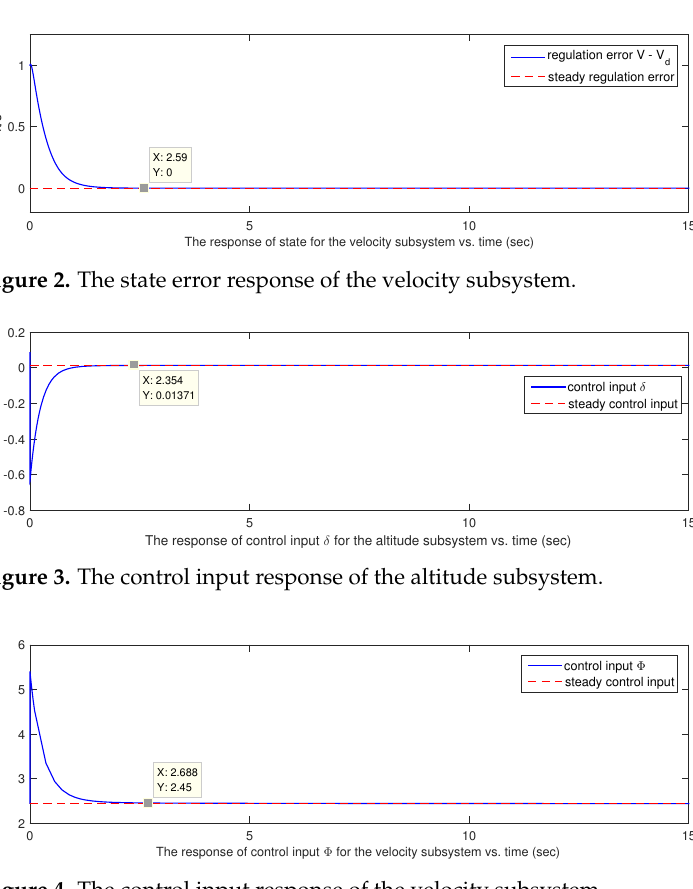
Figure 1. The state responses of the altitude subsystem.